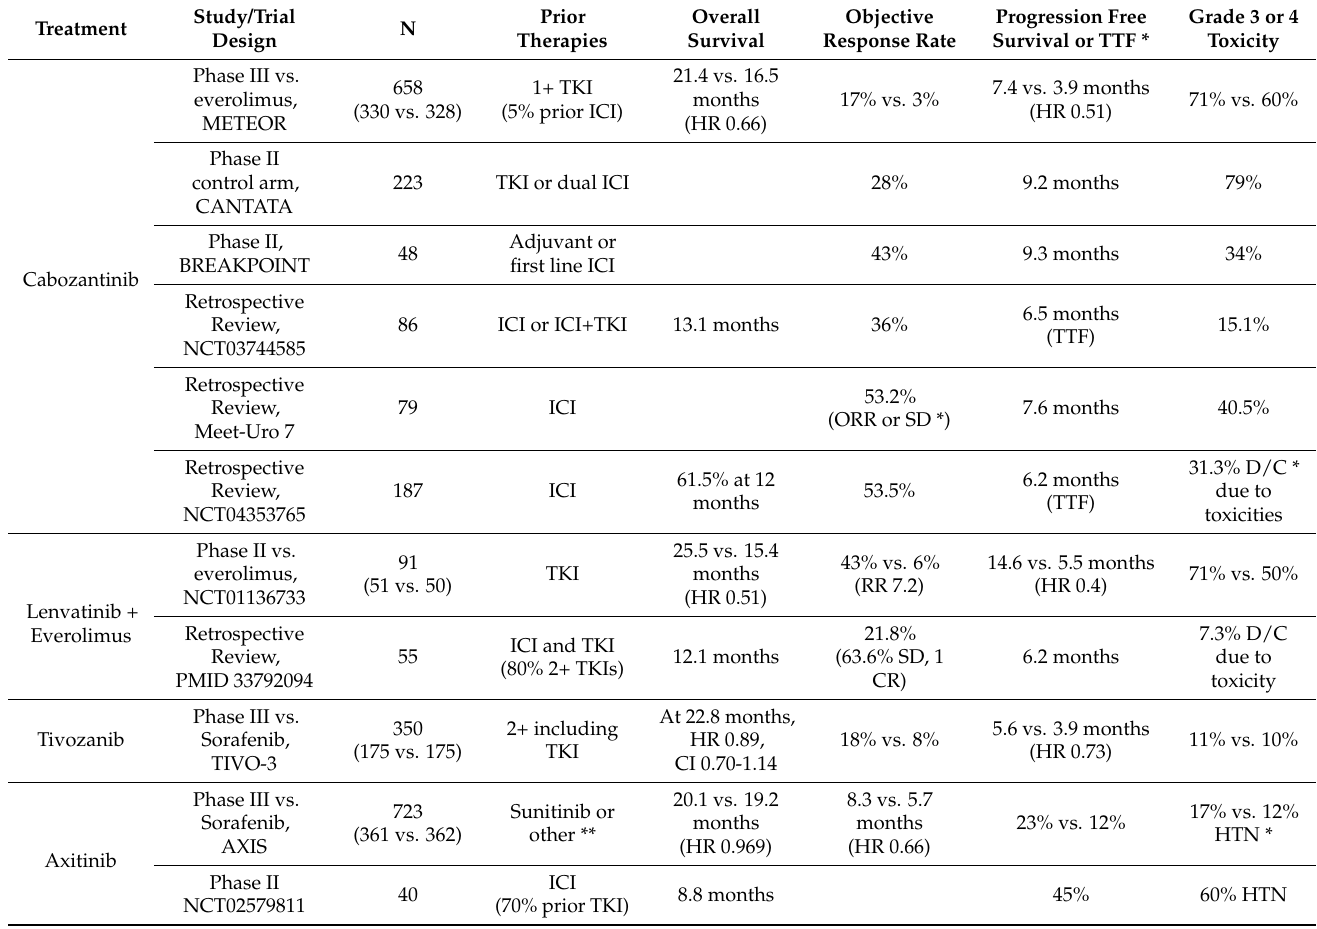
Table 1. VEGFR TKIs in the refractory mRCC setting, with the relevant